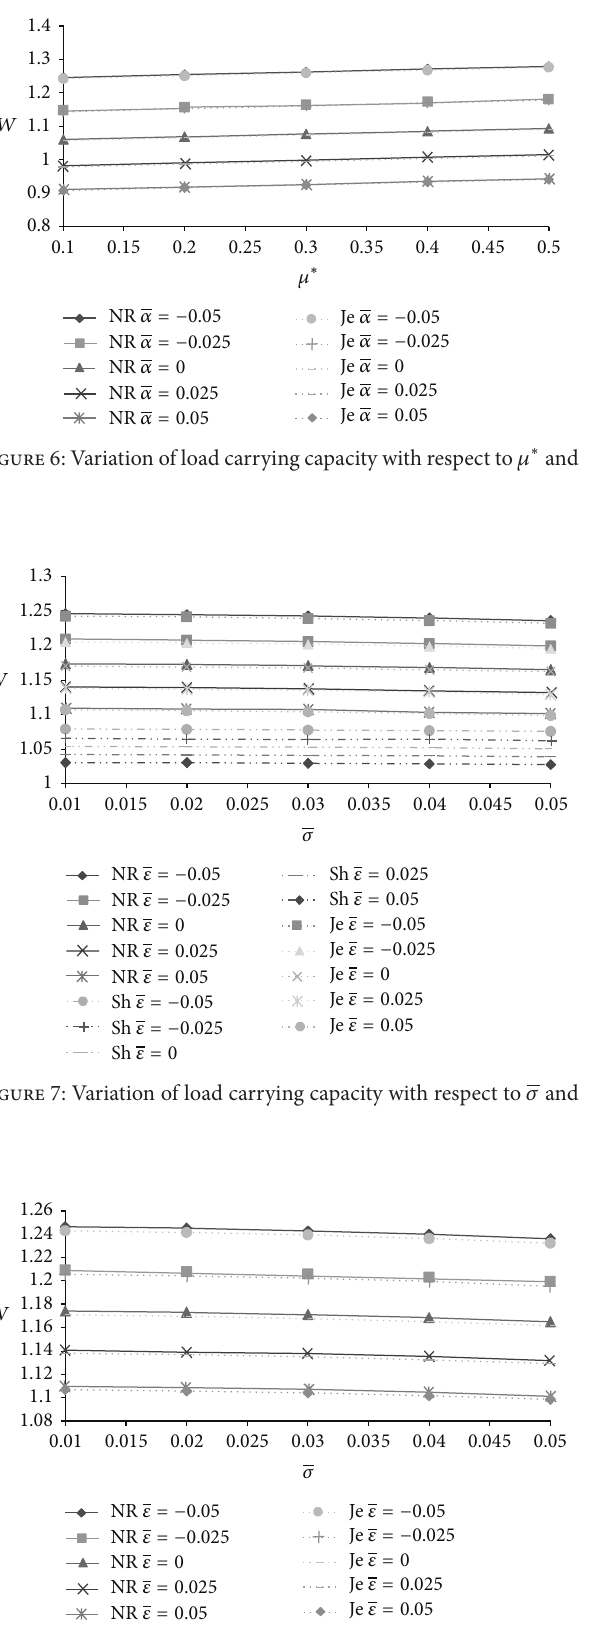
Figure 8: Variation of load carrying capacity with respect to 𝜎 and 𝜀 .